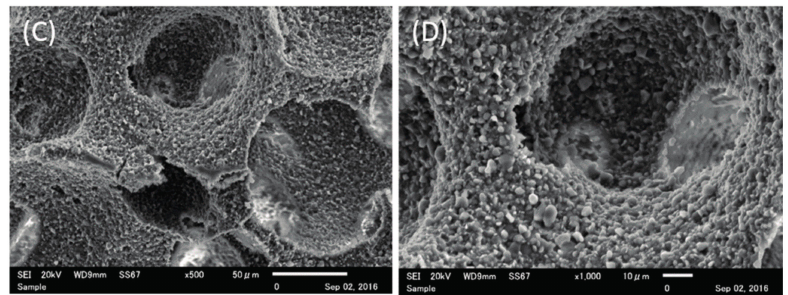
Figure 1. Scanning electron microscope (SEM) image of each sample. (( A , B ) porous hydroxyapatite (HA), ( C , D ) phosphate treated HA). Low-magnification (500 × ) images showing the three-dimensional structure with maintenance of interporous connections ( A , B ). High-magnification (1000 × ) images showing the surface of porous HA with a smooth inner structure ( C ) and phosphate treated HA with a micrometer-scale rough structure created on the pores ( D ).